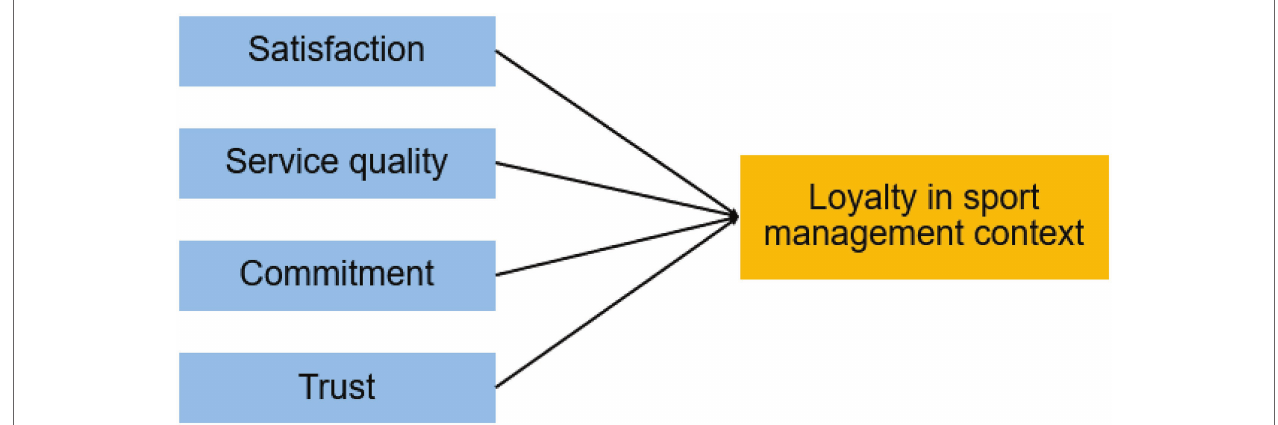
FIGURE 1 | Loyalty and its antecedents in a sport management context.